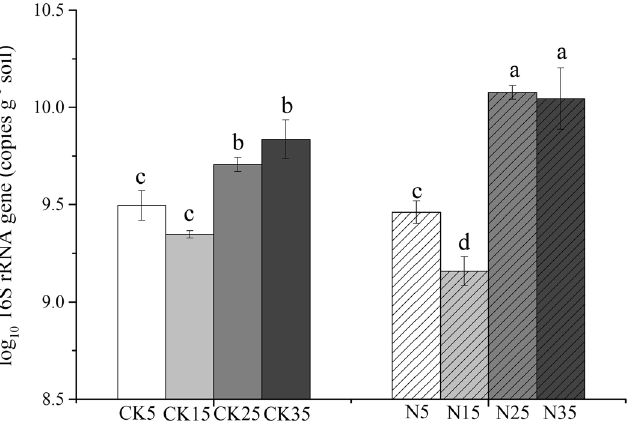
Figure 1. Soil bacterial abundance at different incubation temperatures. Data are presented as mean and standard error (n = 3). Data followed by different letters indicate significant differences ( P < 0.05). CK, soil samples not treated with nitrogen; N, soil samples treated with